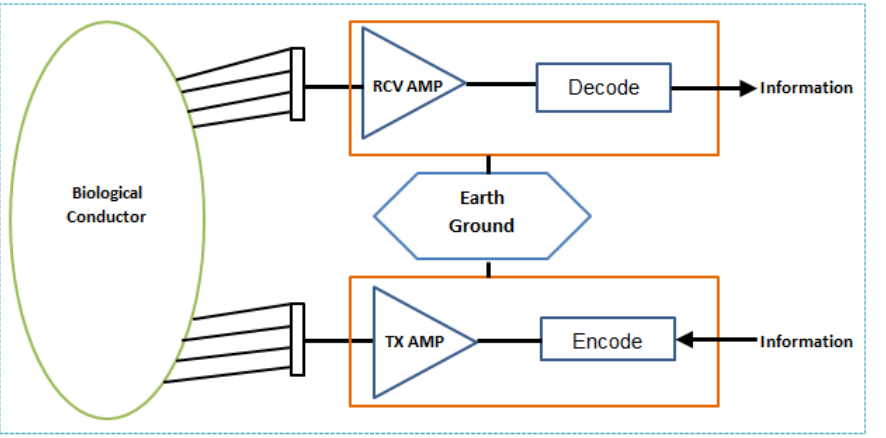
Figure 3. Block diagram of the PAN system.